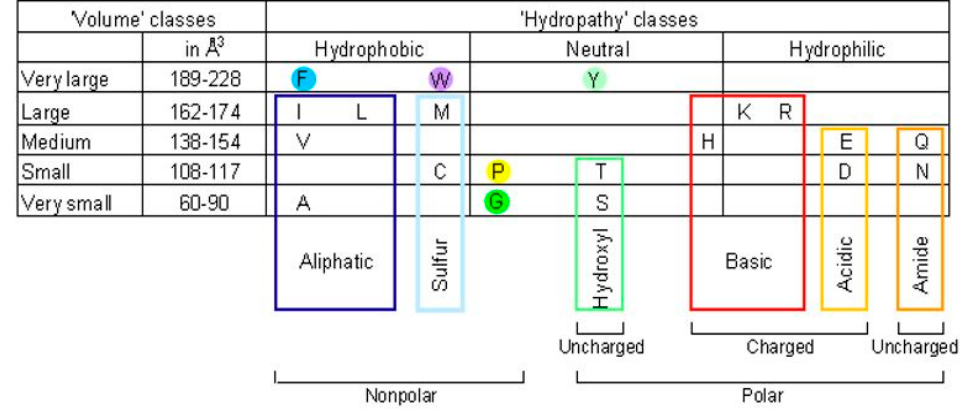
Figure 4. IMGT physicochemical classes of the 20 usual amino acids (AA) [52] (with permission from M-P. Lefranc and G. Lefranc, LIGM, Founders of IMGT ® , the international ImMunoGeneTics information system ® ,